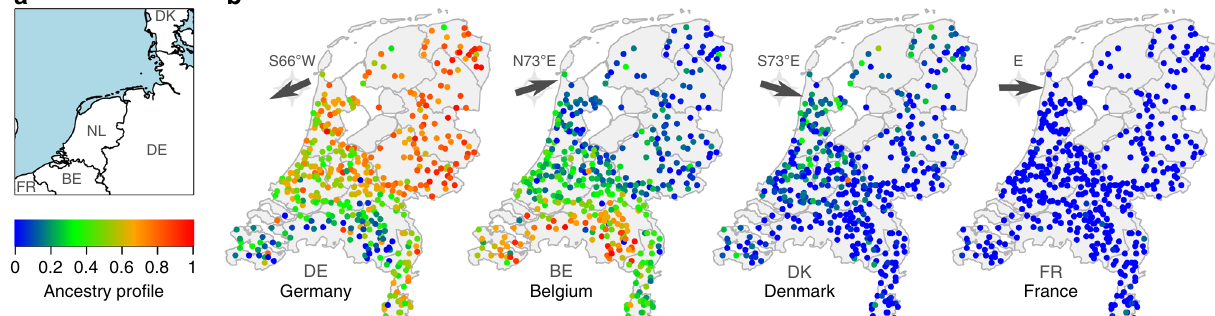
Fig. 2 The ancestry pro fi le of the Netherlands. a The Netherlands and its geographical relationship to neighbouring lands. b German, Belgian, Danish and French haplotypic ancestry pro fi les for 1422 Dutch individuals. Arrows indicate the predominant directions along which the ancestry gradients are arranged across the Netherlands. Map boundary data from the Database of Global Administrative Areas (GADM; https://gadm.org) and Natural Earth (https://